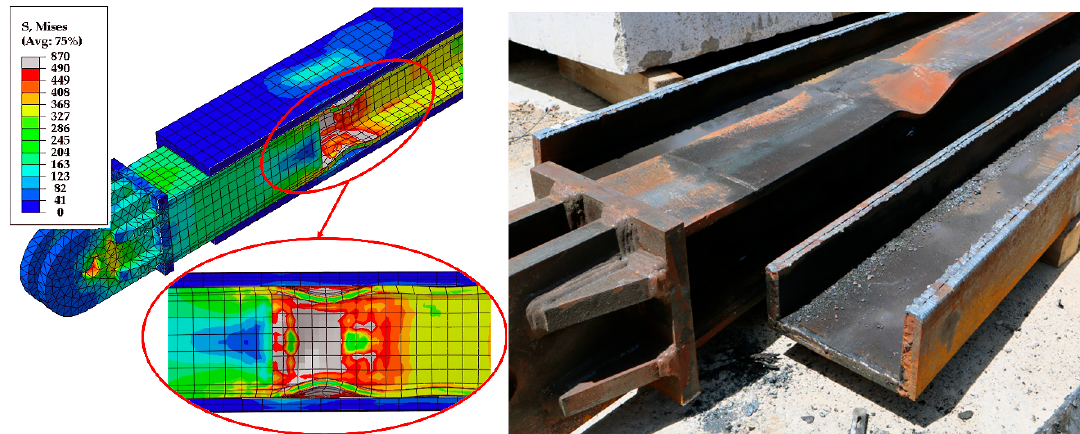
Figure 10. Core flange buckling of Specimen 3 in test and finite element.